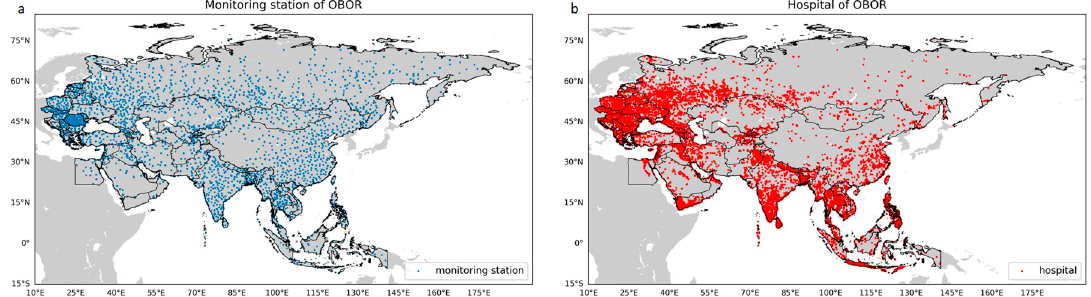
Figure 1. Materials used in this study: ( a ) NCEI monitoring station distribution; ( b ) OSM hospital distribution.